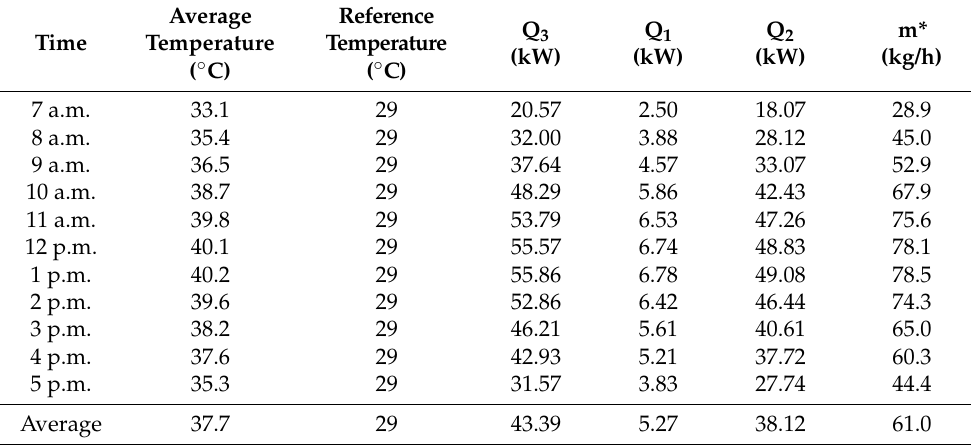
Table 3 was a theoretical prediction of determining the mass water flow for misting